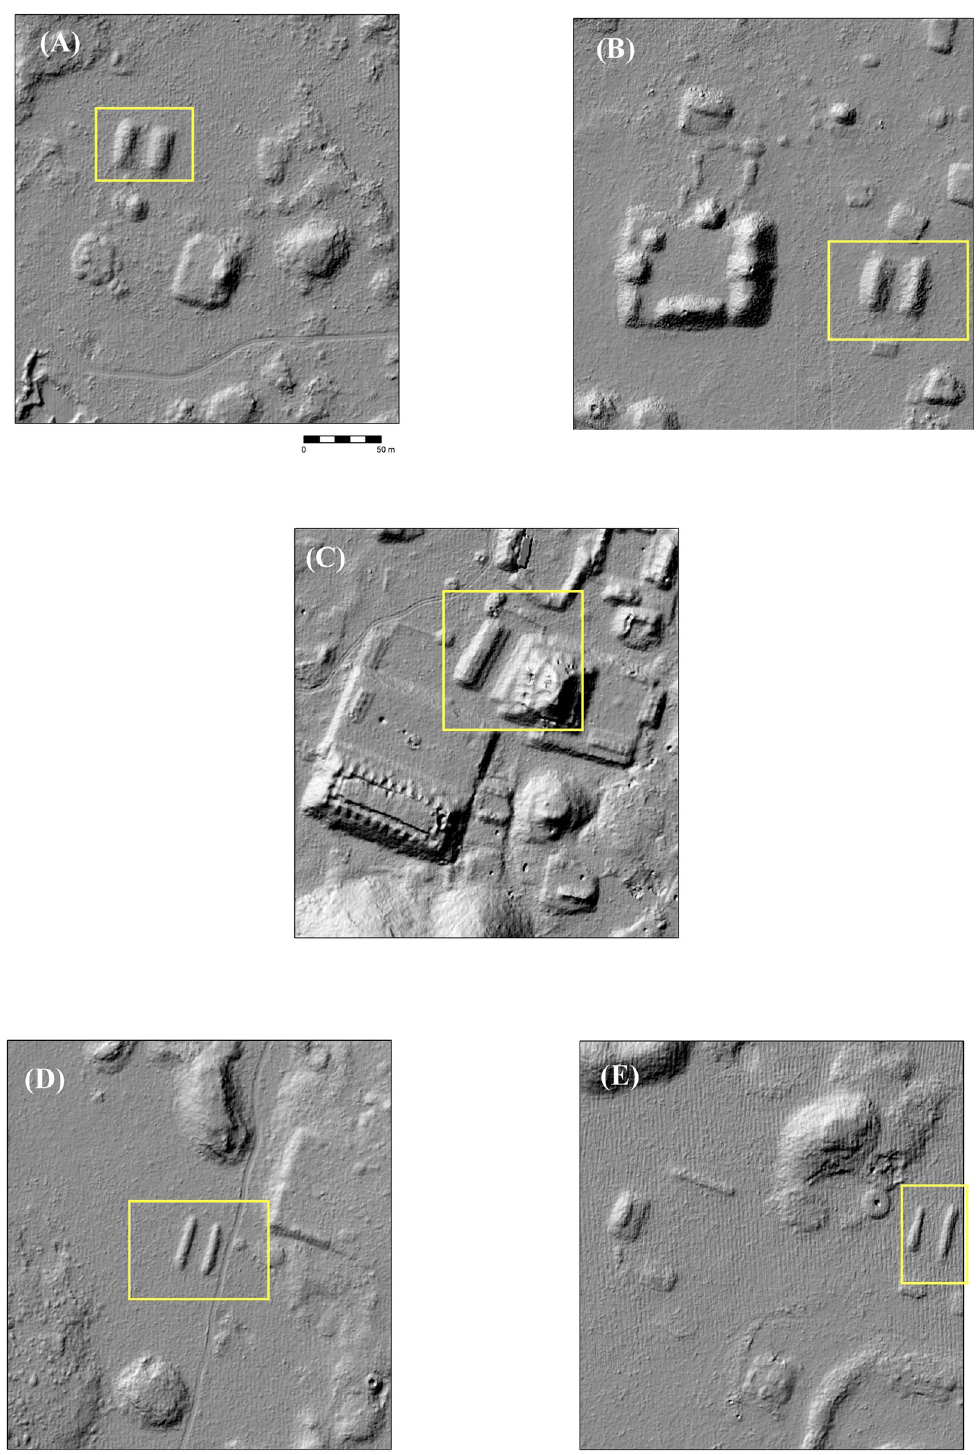
Fig 16. Ballcourts within the lidar sample. (A) a probable Middle Preclassic example near UTM N2233300E231700. (B) a newly identified acropolis, Uchbenmul, possibly dating to the Middle Preclassic. (C) Late-Terminal Classic period example from Sabana Piletas. (D, E) possible small